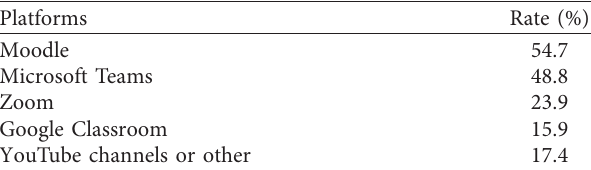
Table 5: Rate of use of distance learning platforms.